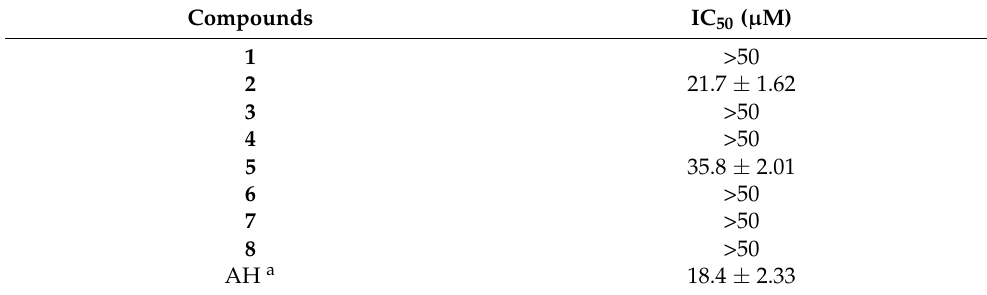
Table 2. IC 50 values of isolated compounds 1 – 8 inhibiting NO production in RAW 246.7 cells.